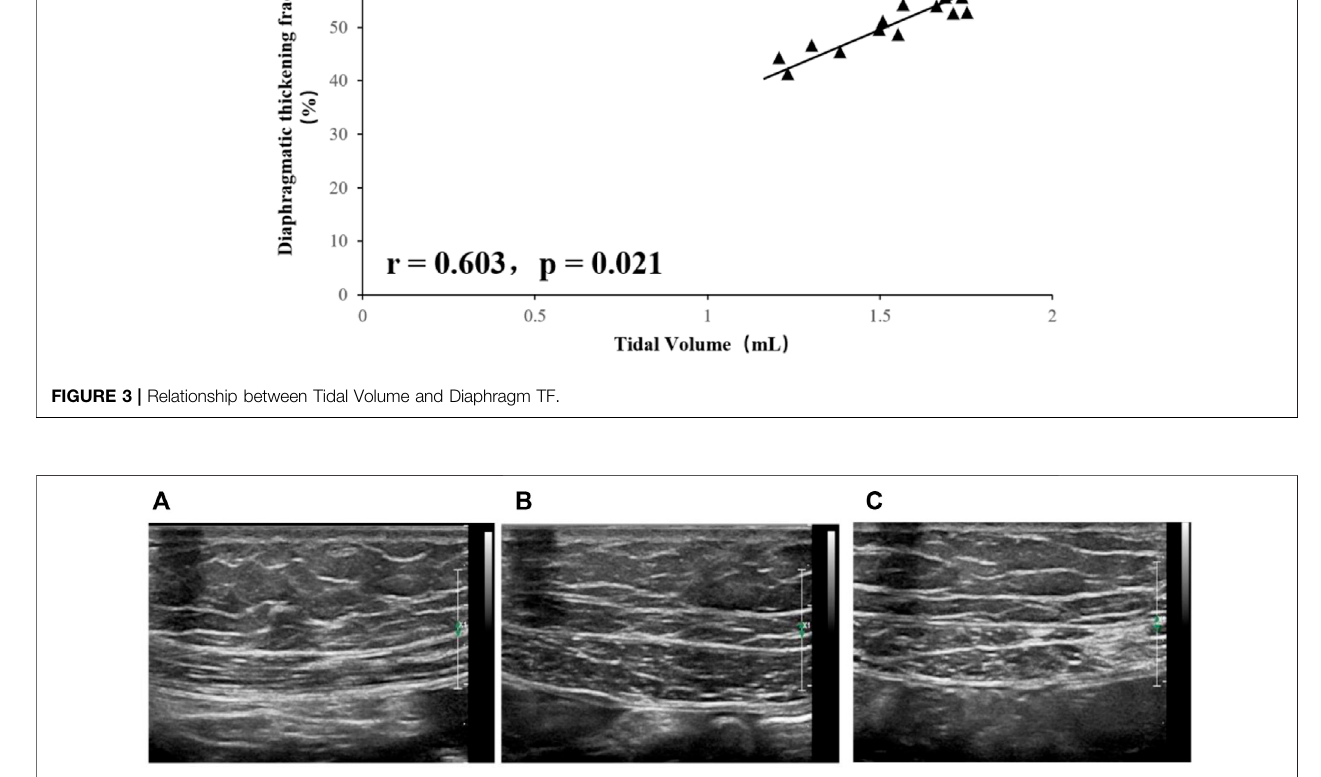
Frontiers in Genetics |